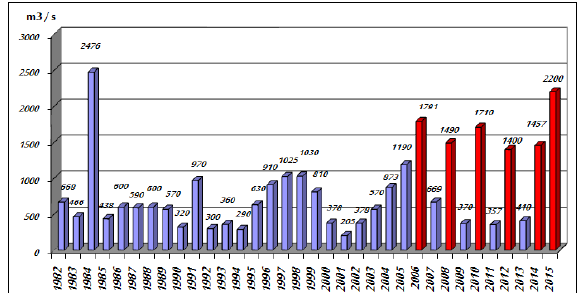
Figure 4. Maximum flow values of Maritsa River measured by DSI between 1982-2015 (Url-3).